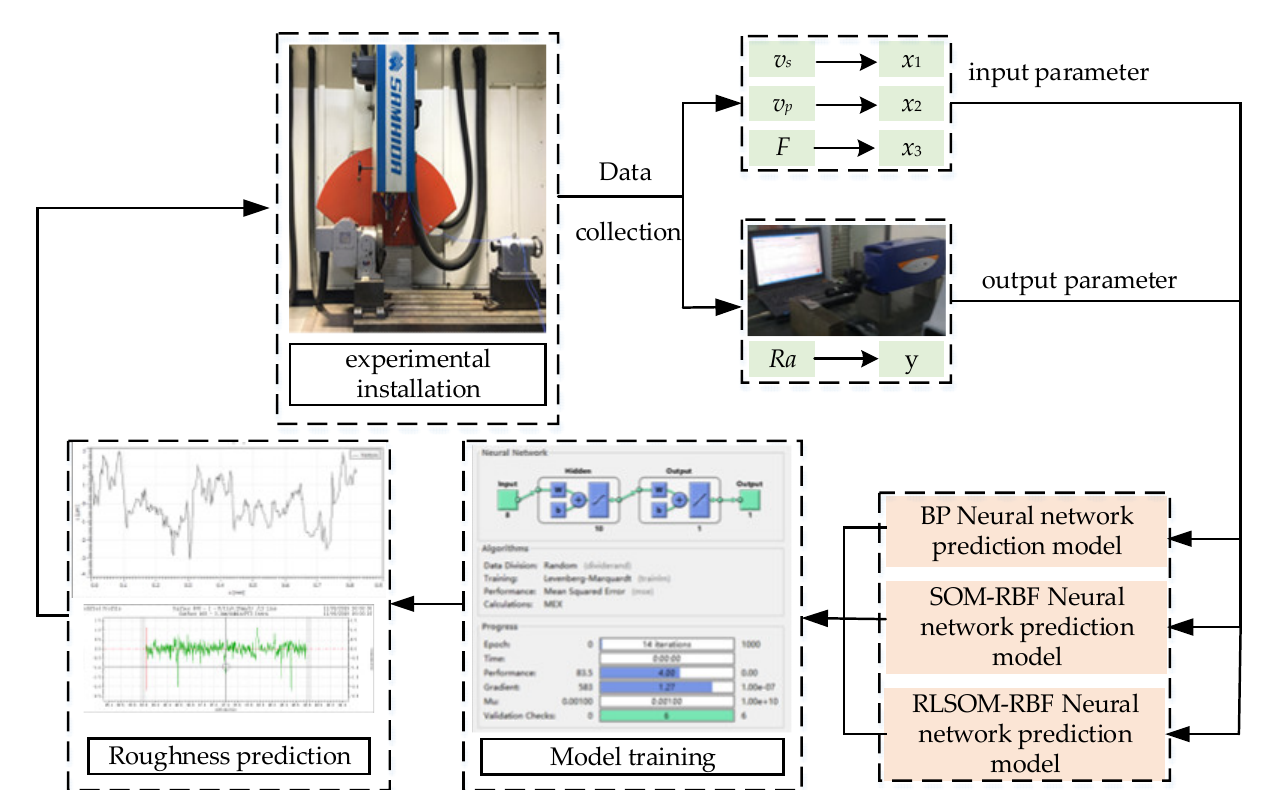
Figure 3. Flowchart of neural network for surface roughness prediction. Table 1. The main relevant parameters of the experiment platform.